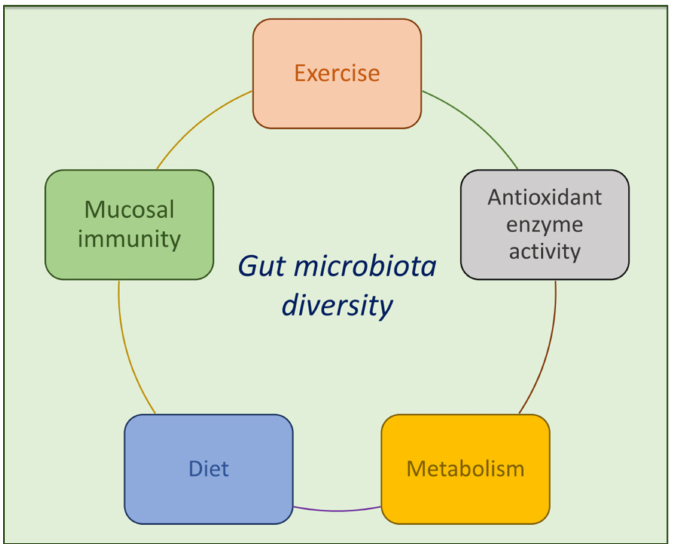
Figure 2. Schematic diagram depicting the factors that contribute to modify the gut microbiota in murine